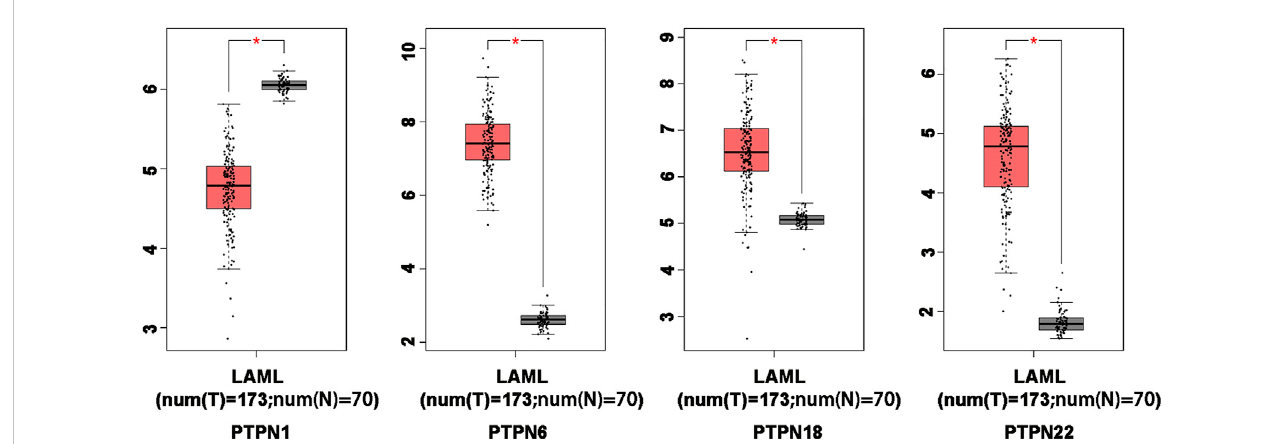
FIGURE 2 Differentially expressed PTPN genes in AML and healthy control samples in the GEPIA database. The fi lter conditions are p -value < 0.05 and the absolute value of the difference (| log2 (Fold Change) |) > 1.